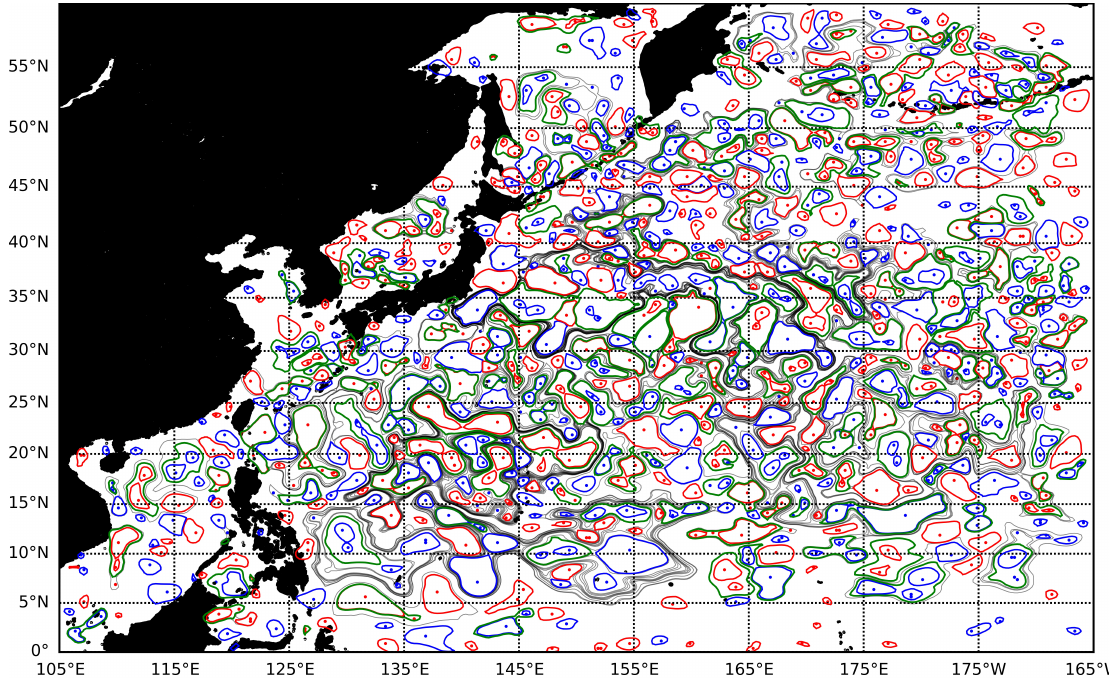
Figure 1. The daily eddytrees detected by our method, including eddies (mononuclear eddies, multicore eddies and eddy seeds) as the leaf nodes, eddygroups (green lines) whose children are all eddies and other eddygroups (black lines). Anticyclonic eddies and cyclonic eddies (except eddy seeds) are represented by red lines and blue lines, respectively, while eddy seeds and the eddy cores of anticyclonic eddies and cyclonic eddies are expressed by red dots and blue